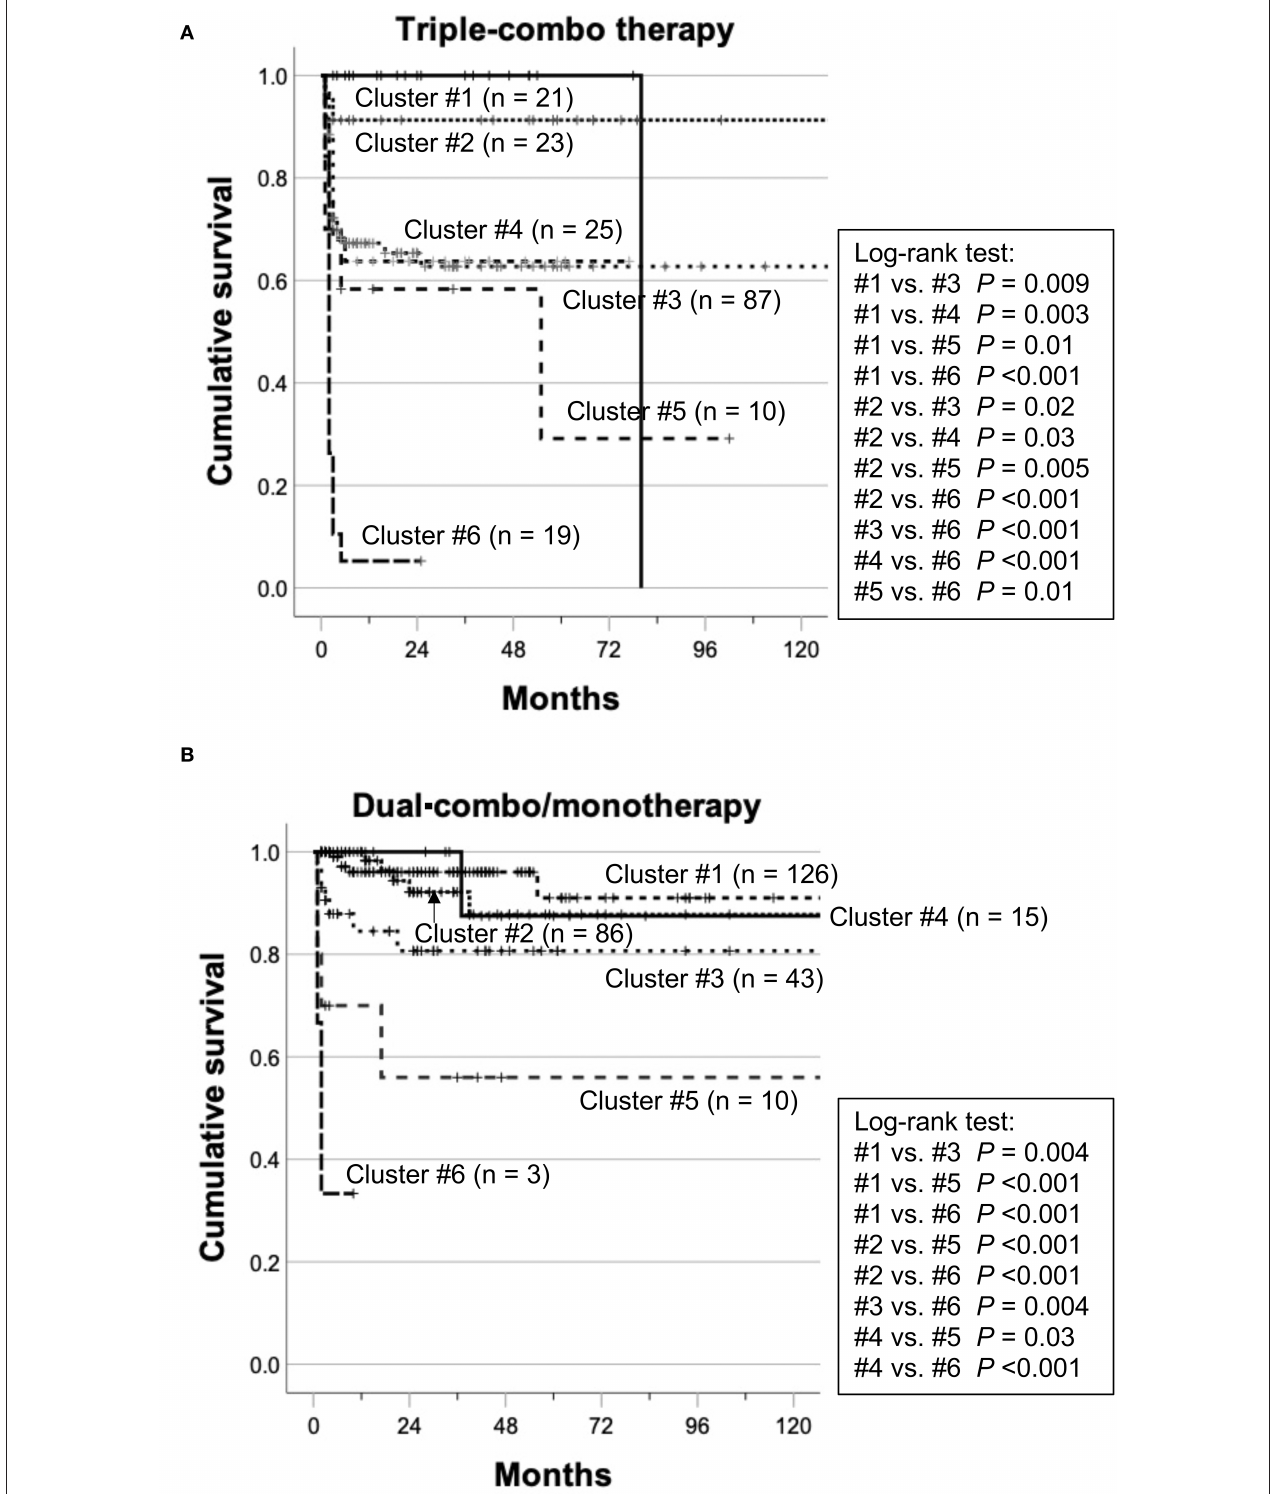
FIGURE 3 | Cumulative survival rates in each cluster in patients treated with initial triple-combo therapy (A) or those treated with initial dual-combo therapy or monotherapy (B) . Cumulative survival rates were compared using Kaplan–Meier analysis, and the log-rank test was used to test for significant differences between two